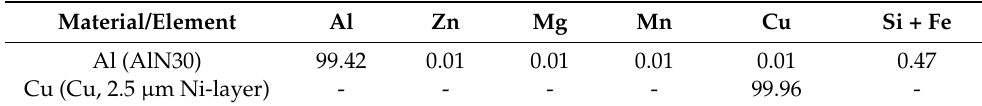
Table 3. Chemical composition of AlN30 and Ni-plated copper in wt. %.